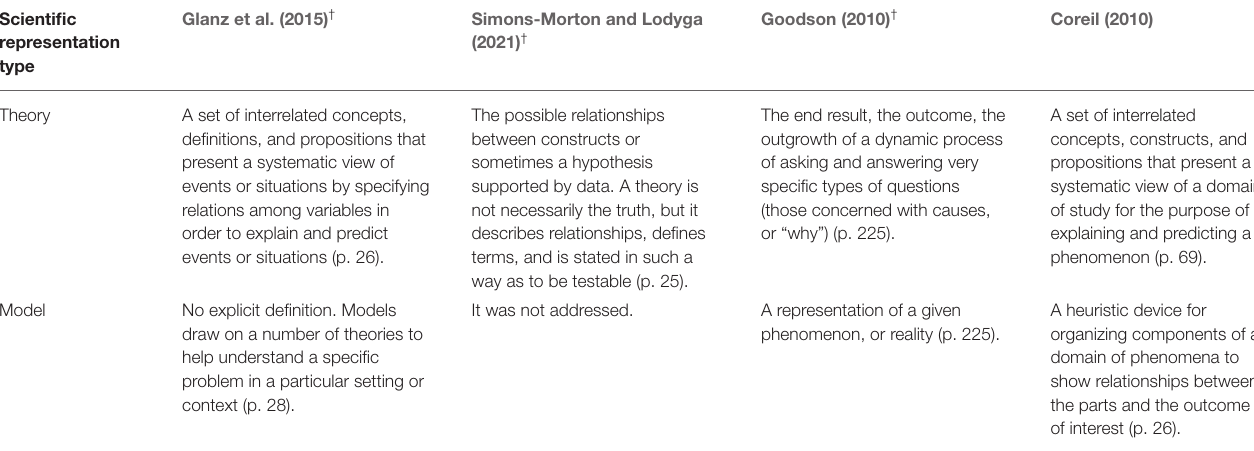
TABLE 1 | Exemplar definitions of theory and models found in the health behavior